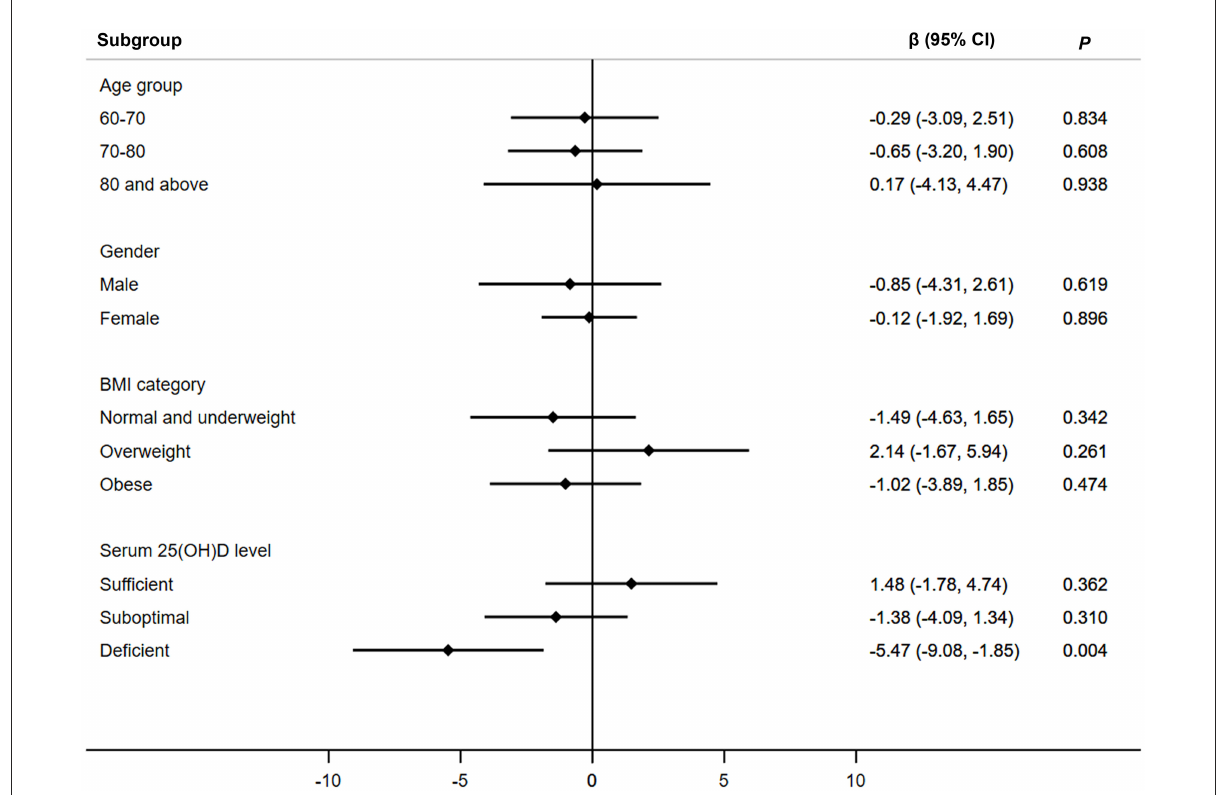
FIGURE1 Associations between low magnesium intake and handgrip strength in different subgroups. Adjusted for age, gender, BMI group, serum 25(OH)D level, race, marital status, education, family monthly poverty level index category, smoke, alcohol drinking, physical activity, energy intake, percentage of total energy from protein, calcium intake, hypertension, diabetes, coronary heart disease, stroke, cancer, and season of examination. Age was not adjusted when participants were stratified by age groups. β , beta coefficient; CI, confidence interval; 25(OH)D, 25-hydroxyvitamin D.